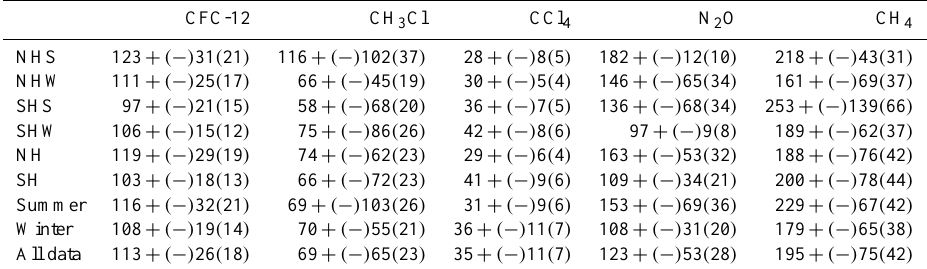
Table 4. The mean lifetimes (yr) of CFC-12, CCl 4 , CH 4 , CH 3 Cl and N 2 O using a CFC-11 lifetime of 45yr. NHS is Northern Hemisphere Summer, NHW is Northern Hemisphere Winter, SHS is Southern Hemisphere summer, SHW is Southern Hemisphere Winter, NH is Northern Hemisphere, SH is Southern Hemisphere. CFC-12 CH 3 Cl CCl